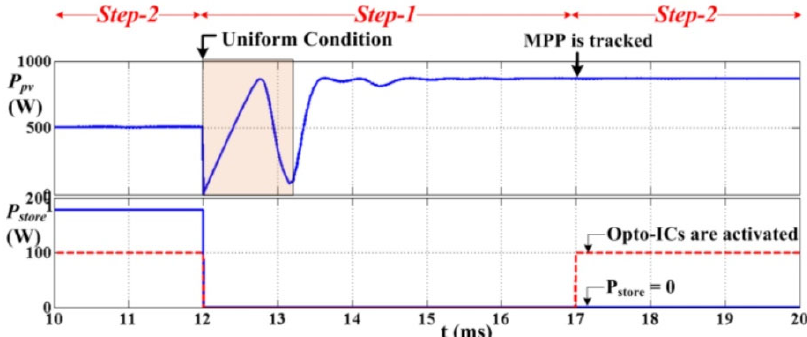
Figure 9. Case 2: zero power is stored during uniform conditions by the proposed scheme.